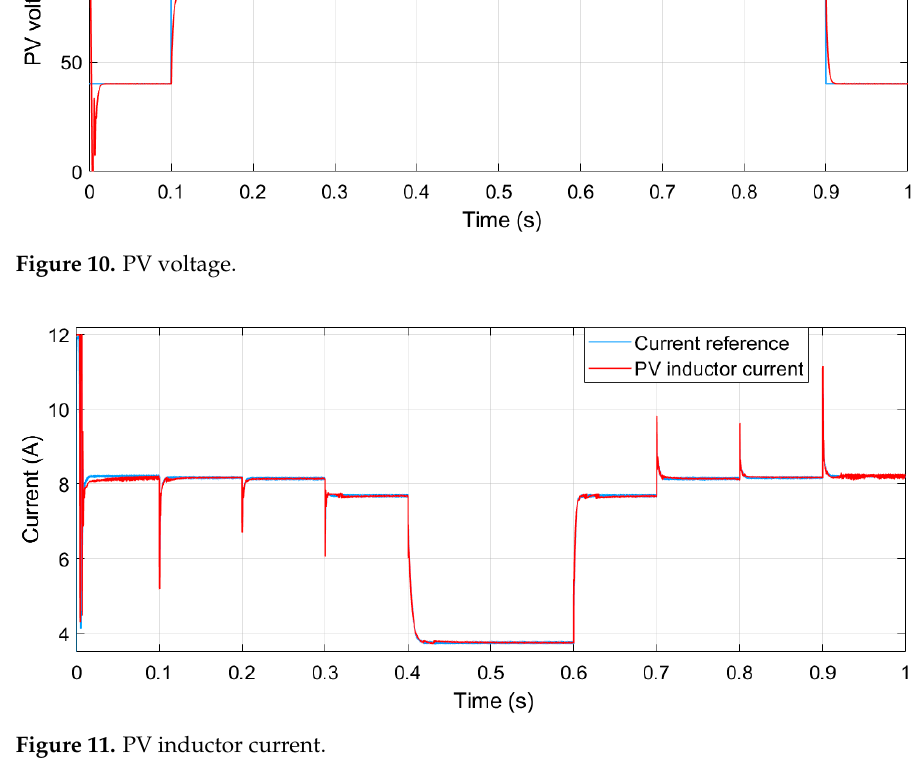
Figure 11. PV inductor current.